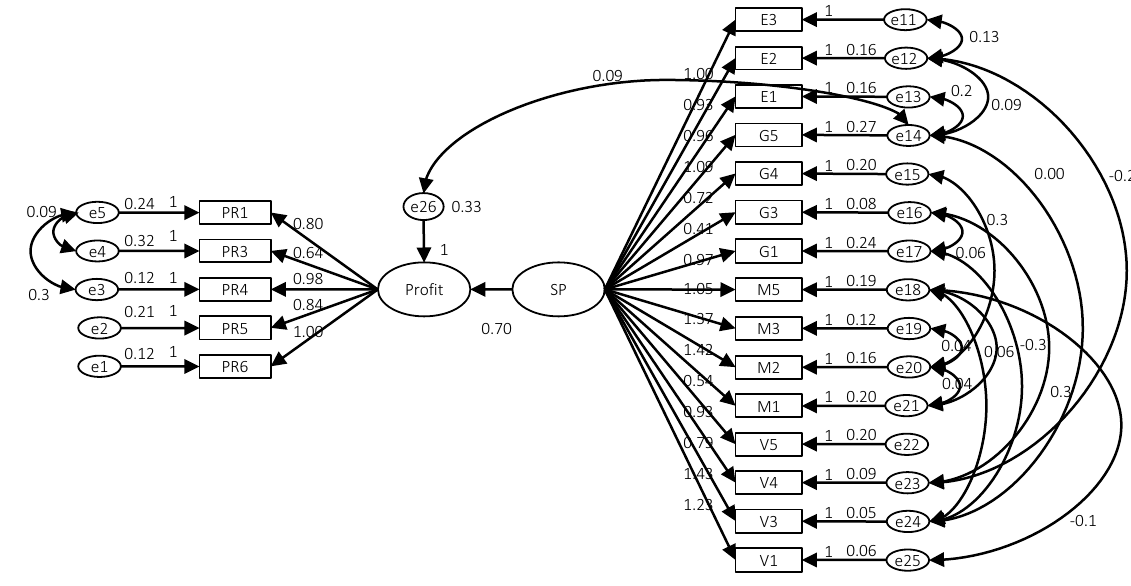
Figure 2. Structural model 1